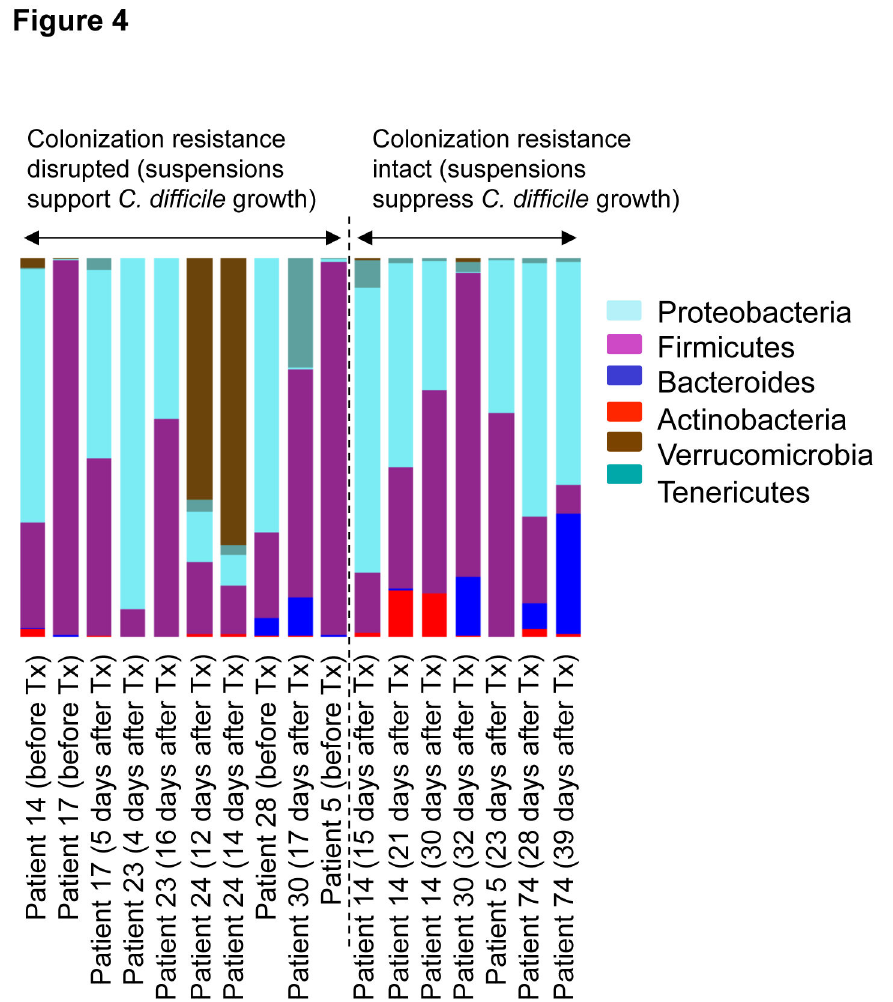
Figure 4. Relative abundance of bacterial phyla in stool of 8 patients treated with oral vancomycin. Stool specimens collected before or after completion of vancomycin therapy for Clostridium difficile infection (CDI), stratified by those with intact (i.e., C. difficile growth suppressed) or disrupted (i.e., C. difficile growth supported) colonization resistance based on the in vitro colonization assay. Micriobiota of each stool specimen was evaluated by deep 16S rRNA sequencing. Each column represents total phyla distribution of one sample. Columns are labelled with sample ID and timing of stool collection in comparison to vancomycin